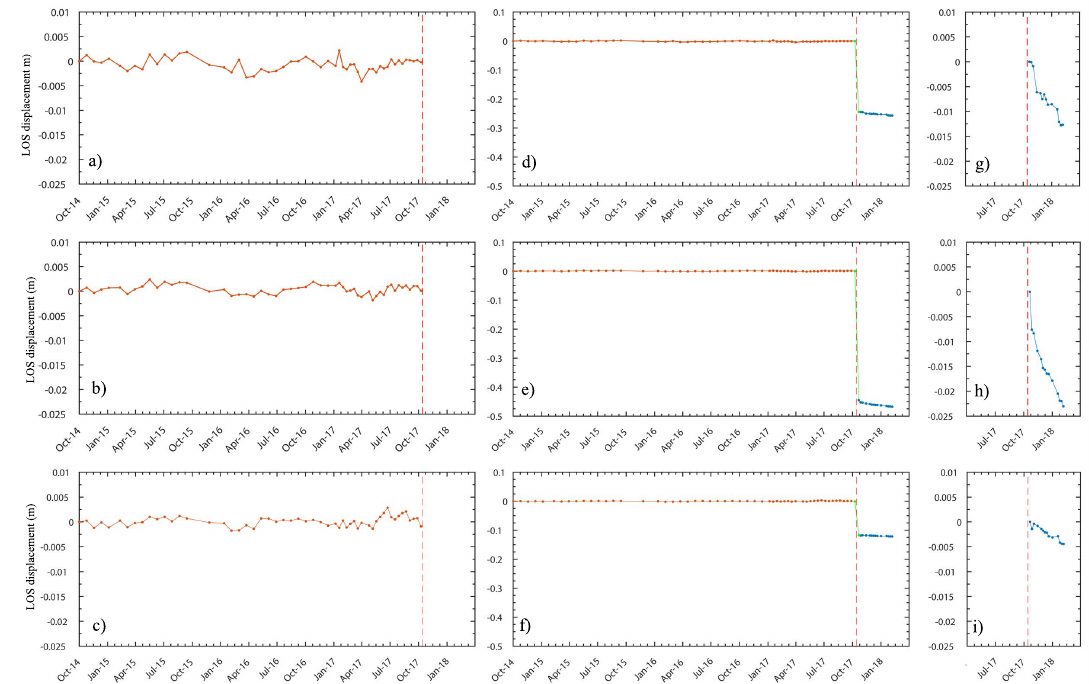
Figure 6. The LOS displacement of two time series: from October 2014 to March 2018 of three points on the Darbandikhan dam crest: M6 (top row), BM14 (middle row), and BM17 (bottom row). The location of each point is indicated in Figure 5a. ( a – c ) The time series of the displacement before the earthquake. ( d – f ) The time series before and after the earthquake is connected using the co-seismic movement estimated from GPS and levelling. ( g – i ) The post-seismic movement estimated from the SBAS time series. The ranges of panels ( a – c ) and ( g – i ) are identical. Note, to be consistent with GPS and levelling displacements, interferometric synthetic aperture radar (InSAR)-derived displacements were multiplied with − 1, so that positive implies that the Earth’s surface moved towards the radar sensor (i.e., uplift in the radar LOS), and negative implies subsidence in the radar